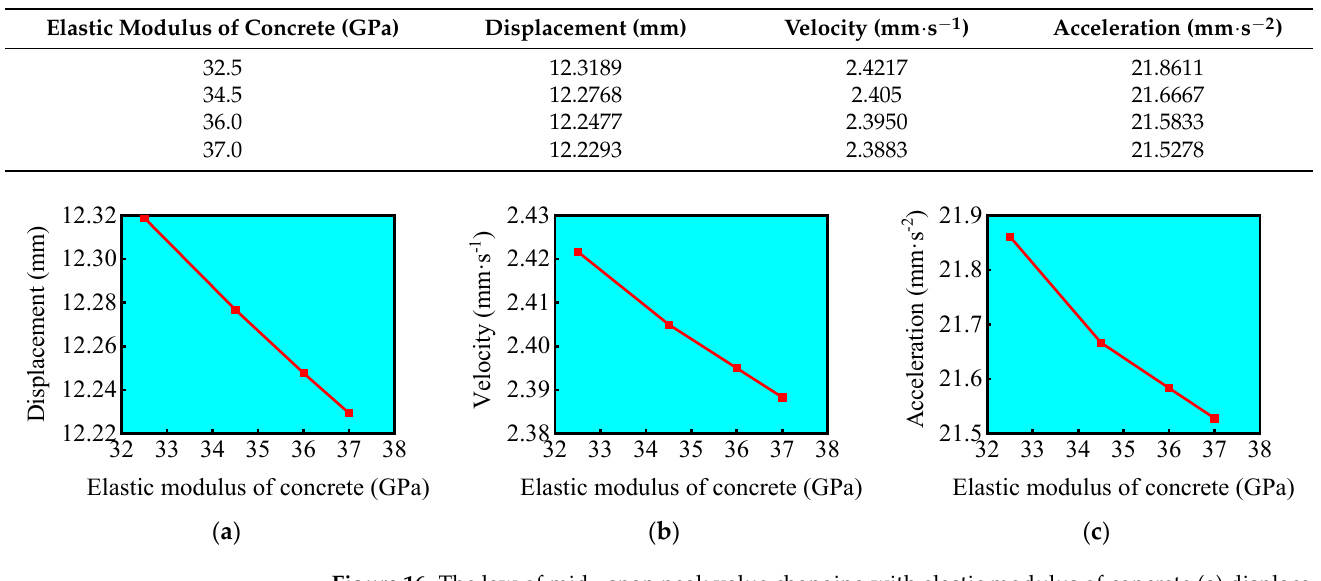
Figure 16. The law of mid − span peak value changing with elastic modulus of concrete ( a ) displace- ment, ( b ) velocity, and ( c ) acceleration.